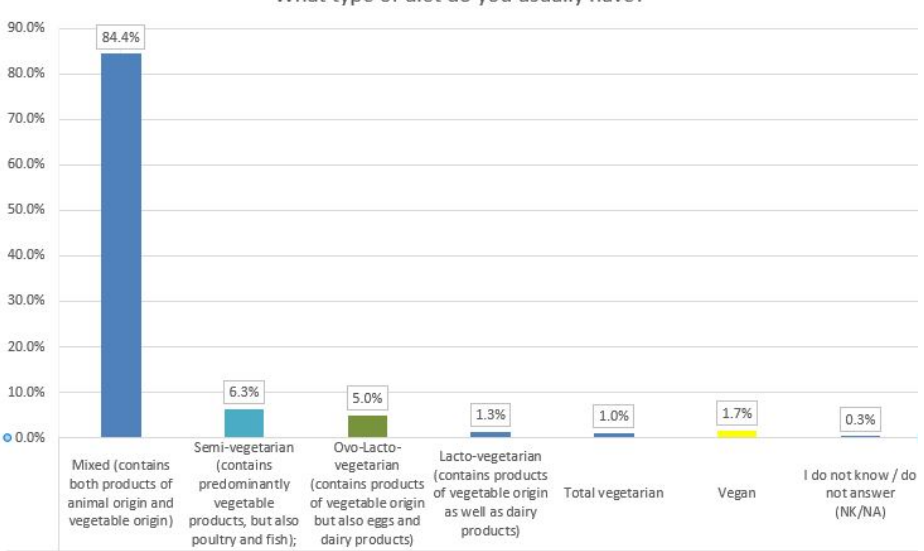
Figure 3. The educational level of the responders.